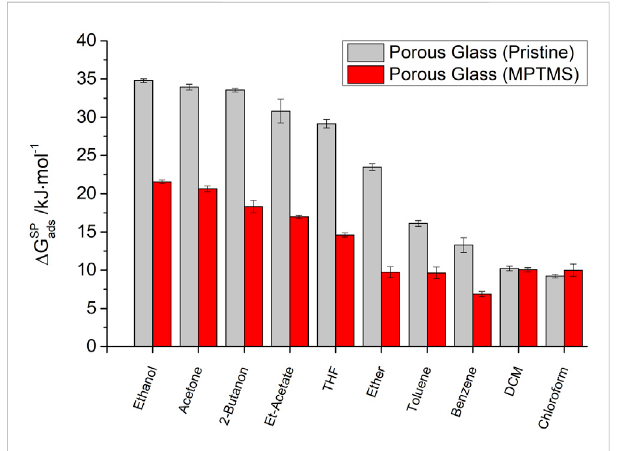
FIGURE 4 Polar component ofthefreeenergyofadsorption Δ G SP ads at120 ° C for polar probe molecules on macro-porous silica before (gray) and after (red) surface modi fi cation with MPTMS.